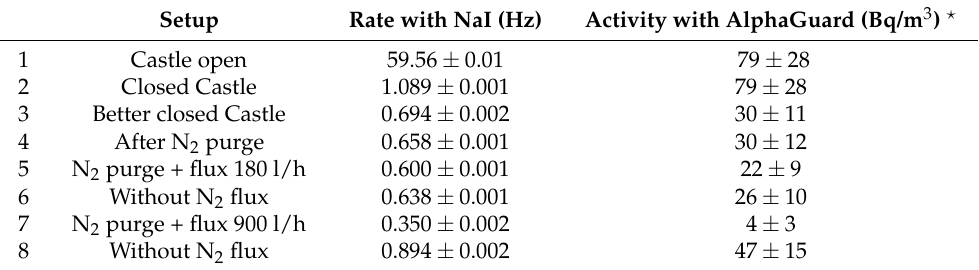
Table 2. Measurements of the contribution of the NEXT Castle in different tests. Setup Rate with NaI (Hz) Activity with AlphaGuard (Bq/m 3 )